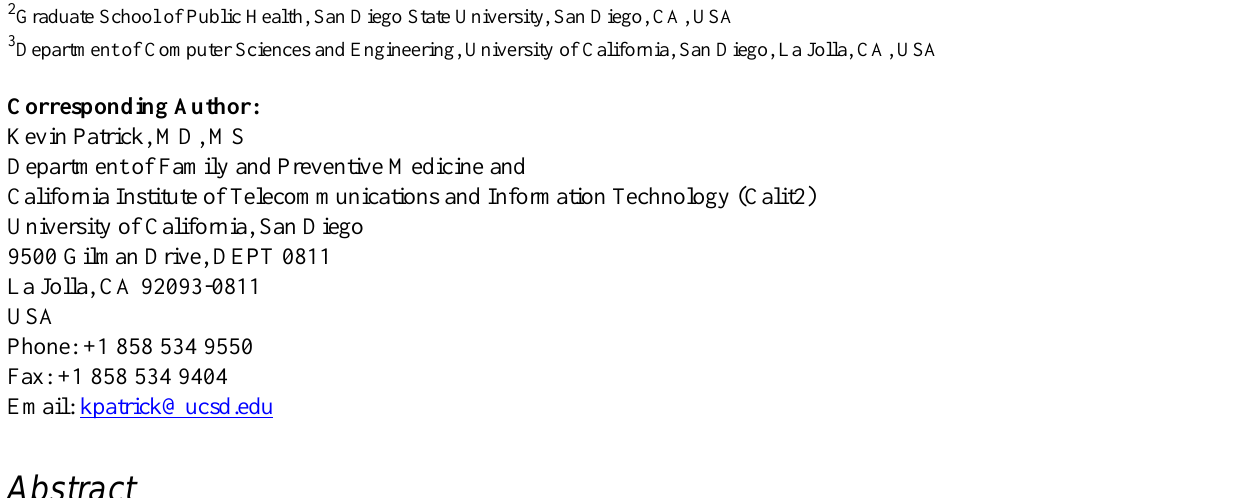
Mobile phone; obesity; SMS; text message; health